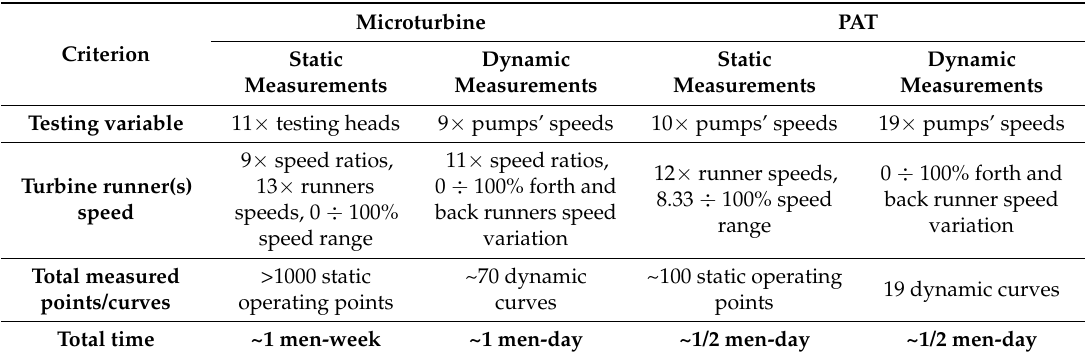
Table 7. Final balance between the two testing methods.